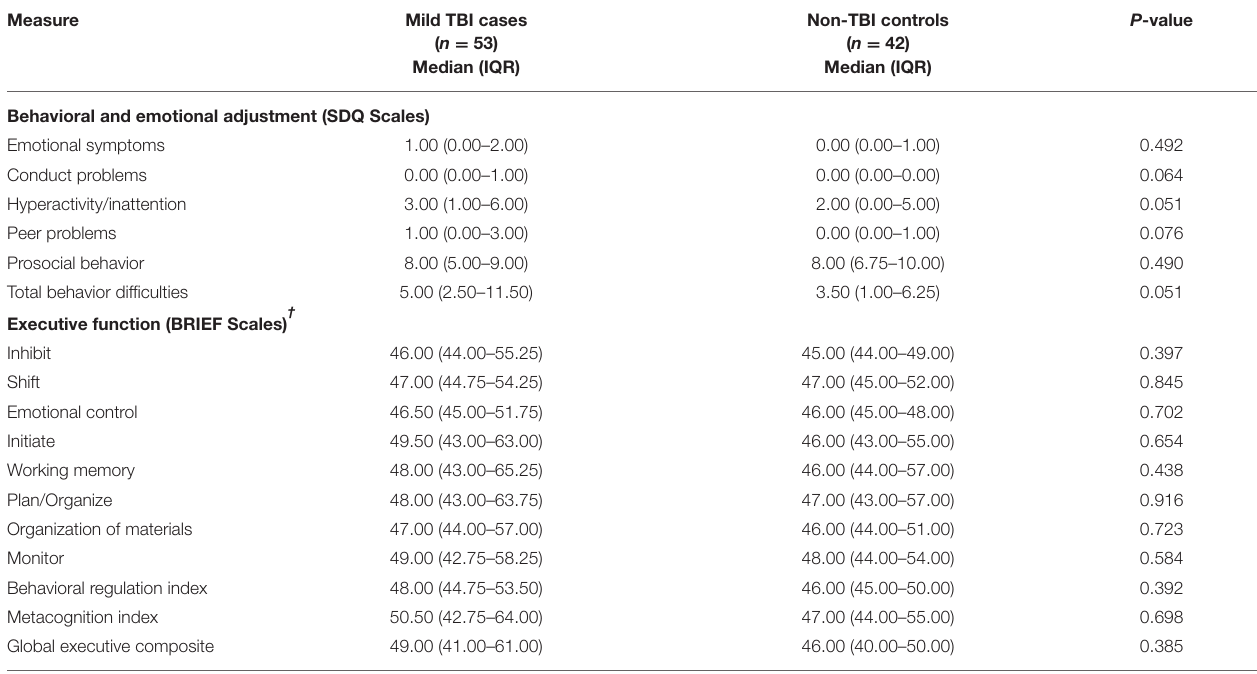
TABLE 3 | Teacher-reported child outcomes for mild TBI cases and non-TBI controls (Aim 2). Measure